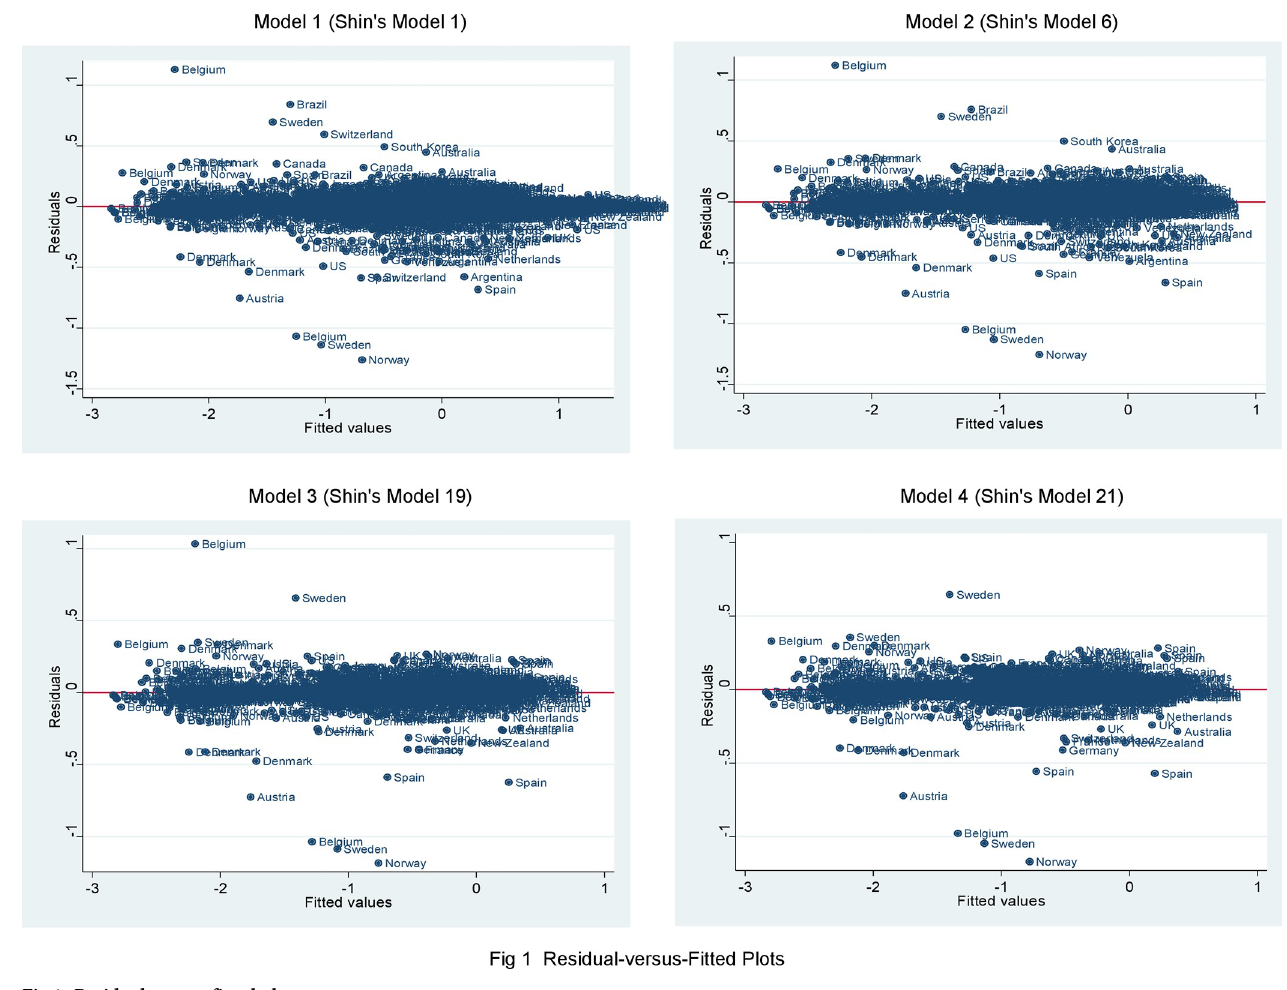
Fig 1. Residual-versus-fitted